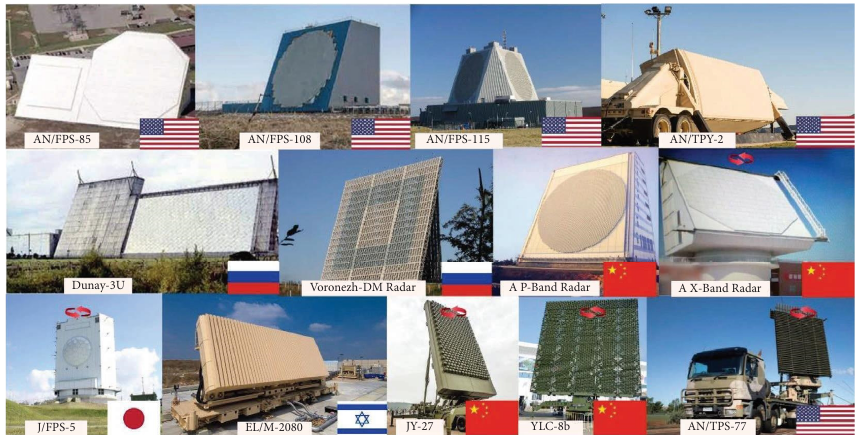
Figure 3: Typical GBR and vehicle-mounted anti-stealth radar in the world.